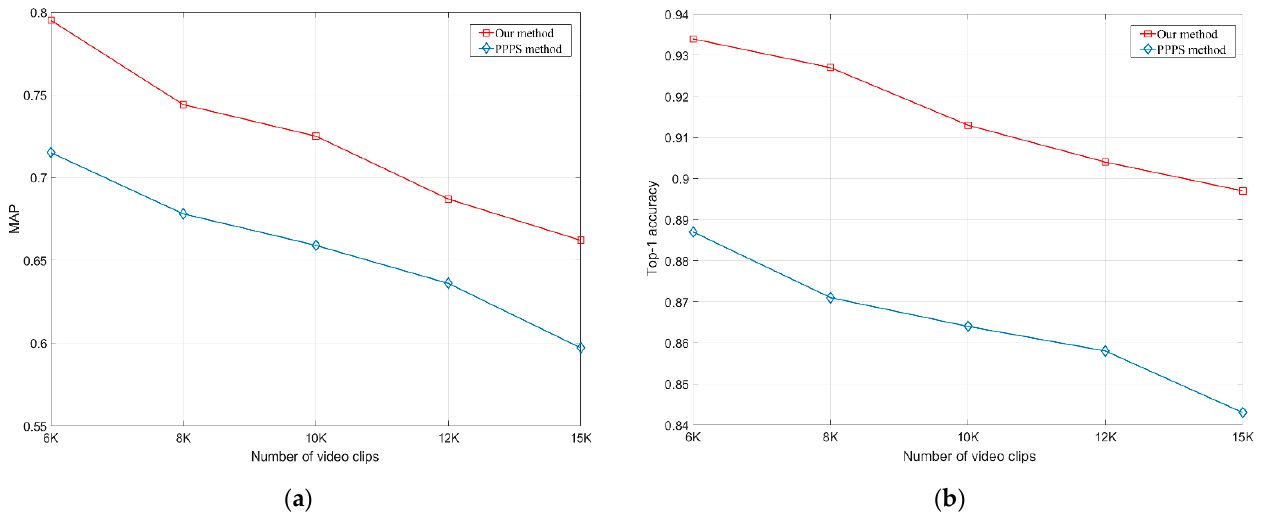
Figure 7. The accuracy comparison between our method and the RCNN method with different num- bers of video clips: ( a ) MAP comparison; ( b ) Top-1 accuracy comparison.